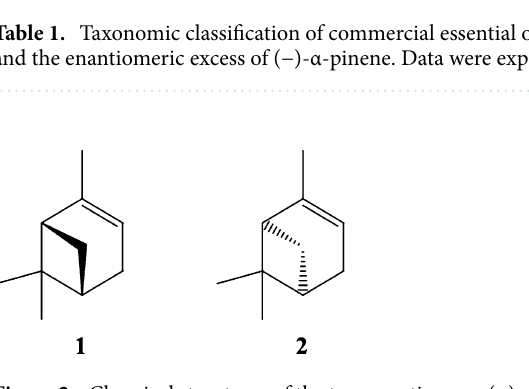
Figure 2. Chemical structures of the two enantiomers: (−)-α-pinene ( 1 ) and (+)-α-pinene ( 2 ).